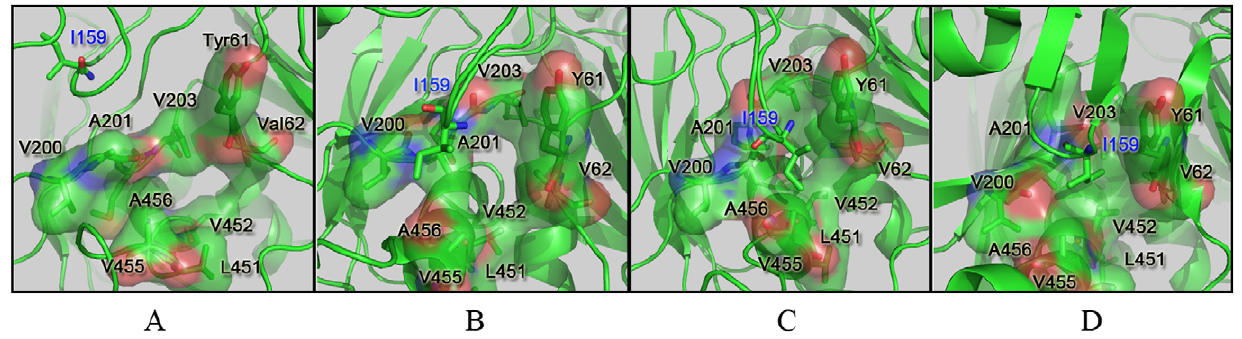
Figure 7. Changes of the hydrophobic pocket and its hydrophobic interaction to Ile159 along the TMD simulation, with snapshots at 900 ps (A), 920 ps (B), 980 ps (C) and 990 ps